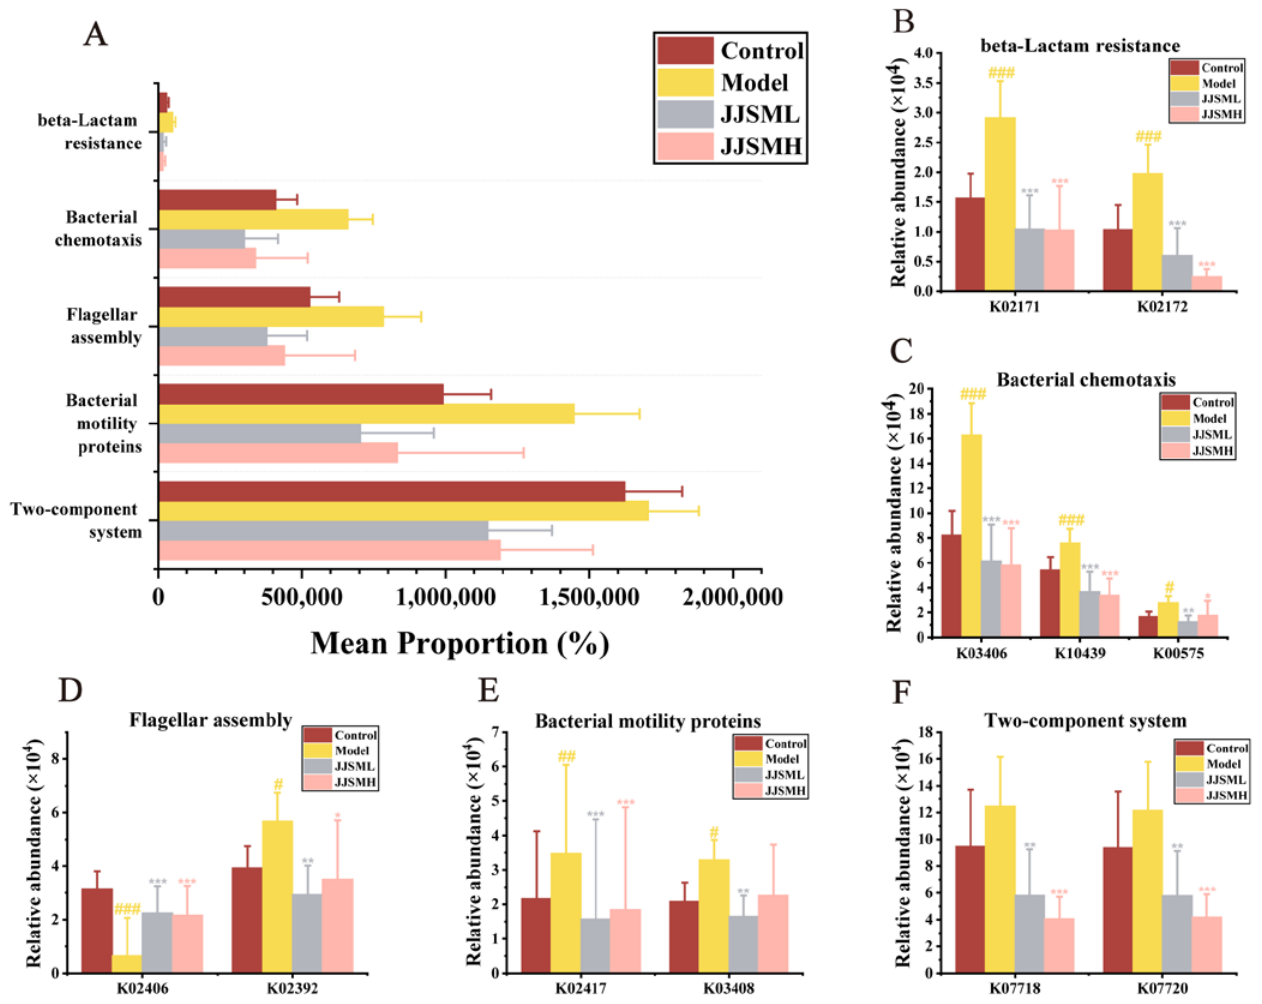
Figure 5. Function prediction. ( A ) Level 3 KEGG pathway alterations. KOentries with dominant abundance and significant differences in the pathway. ( B ) Beta-Lactam resistance; ( C ) Bacterial chemotaxis; ( D ) Flagellar assembly; ( E ) Bacterial motility proteins; ( F ) Two-component system. # p < 0.05 vs. control, ## p < 0.01 vs. control, ### p < 0.001 vs. control, * p < 0.05 vs. model, ** p < 0.01 vs. model, *** p < 0.001 vs. model.